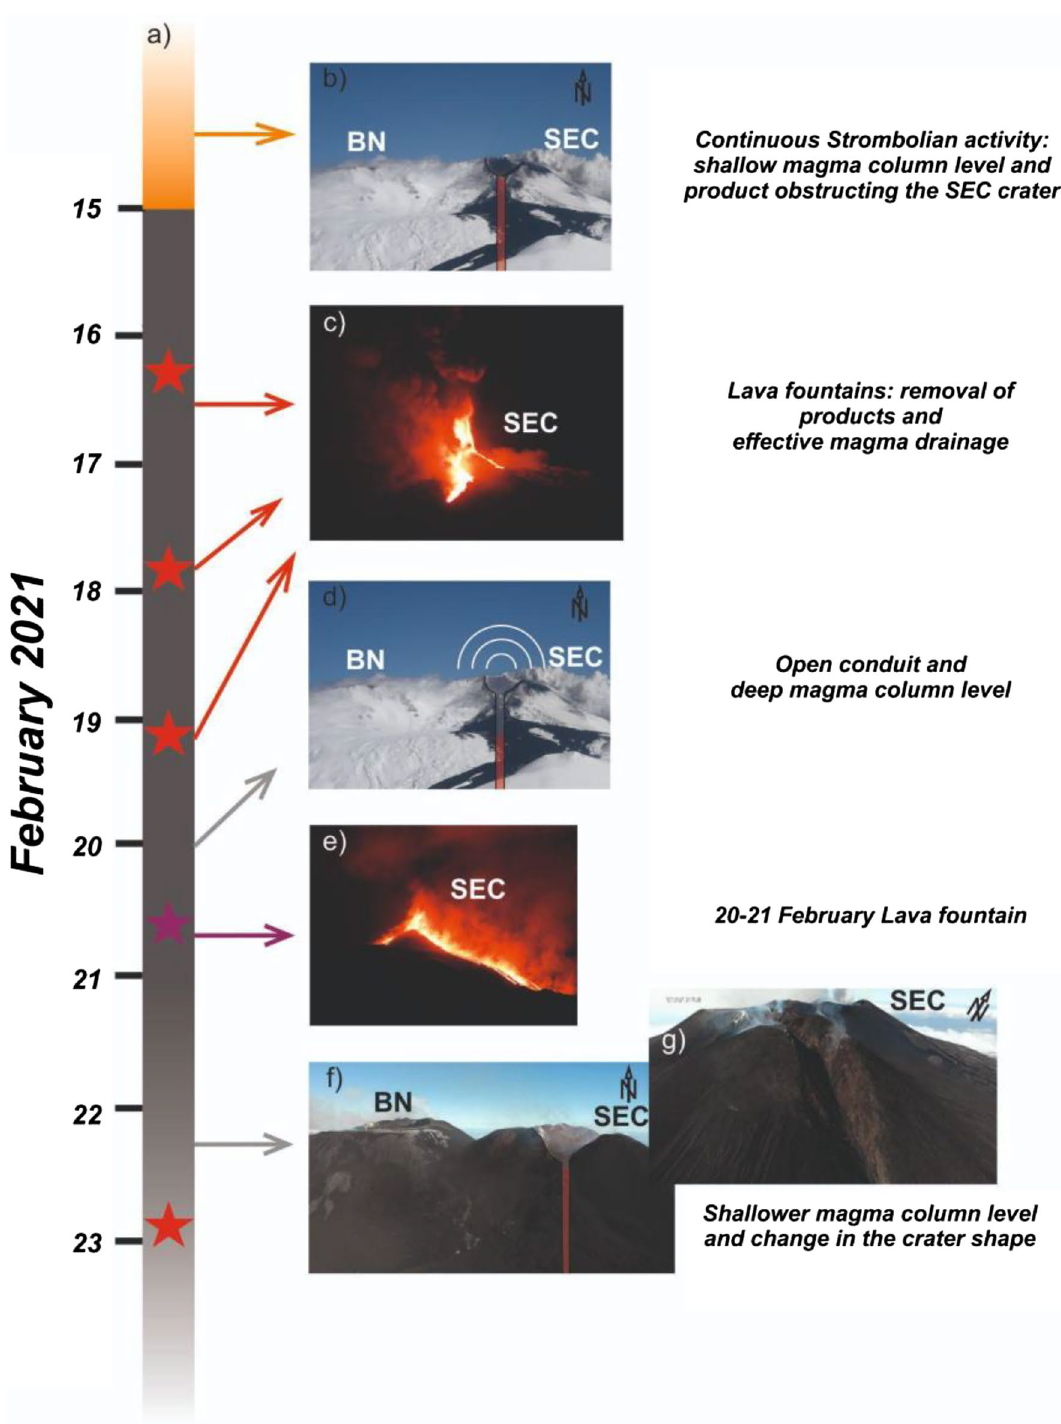
Figure 10. ( a ) Timeline of the volcanic phenomena preceding and following the observed gliding signals, with red stars indicating lava fountain episodes in the time period 16—19 February, and purple star the 20 February lava fountain episode (episode #4), which is the focus of this study; ( b ) photo of Etna summit crater with a schematic cartoon of the shallower portion of SEC feeding system representing hypothesized conduit condition and magma level before the onset of the paroxysmal activity period; ( c ) photo of the 16 February lava fountain (courtesy of Boris Behncke); ( d ) photo of Etna summit crater with a schematic cartoon of the shallower portion of SEC feeding system representing hypothesized conduit condition and magma level leading to gliding phenomenon; ( e ) photo of episode #4 (courtesy of Boris Behncke); ( f ) photo taken on 3 March of Etna summit craters with a schematic cartoon of the shallower portion of SEC feeding system representing hypothesized conduit condition and magma level after episode #4 and g) photo showing SEC shape after 22 February. Images b,d,f and g were taken by co-author Massimo Cantarero, the UAS